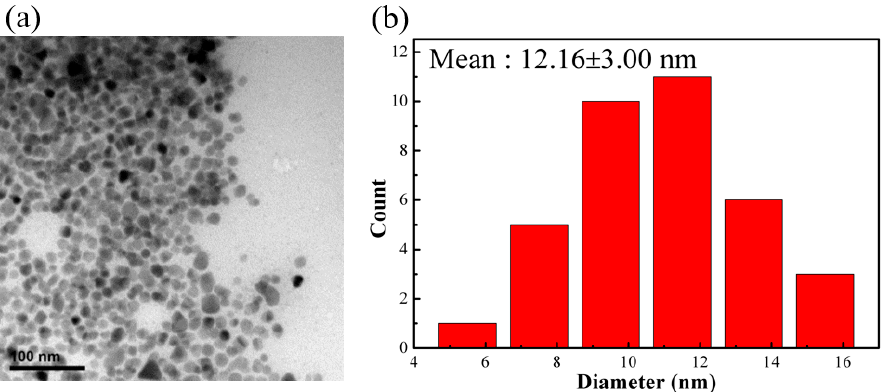
Figure 1. ( a ) TEM image of surfactant-modified Fe 3 O 4 nanoparticles (scale bar = 100 nm); ( b ) particle size